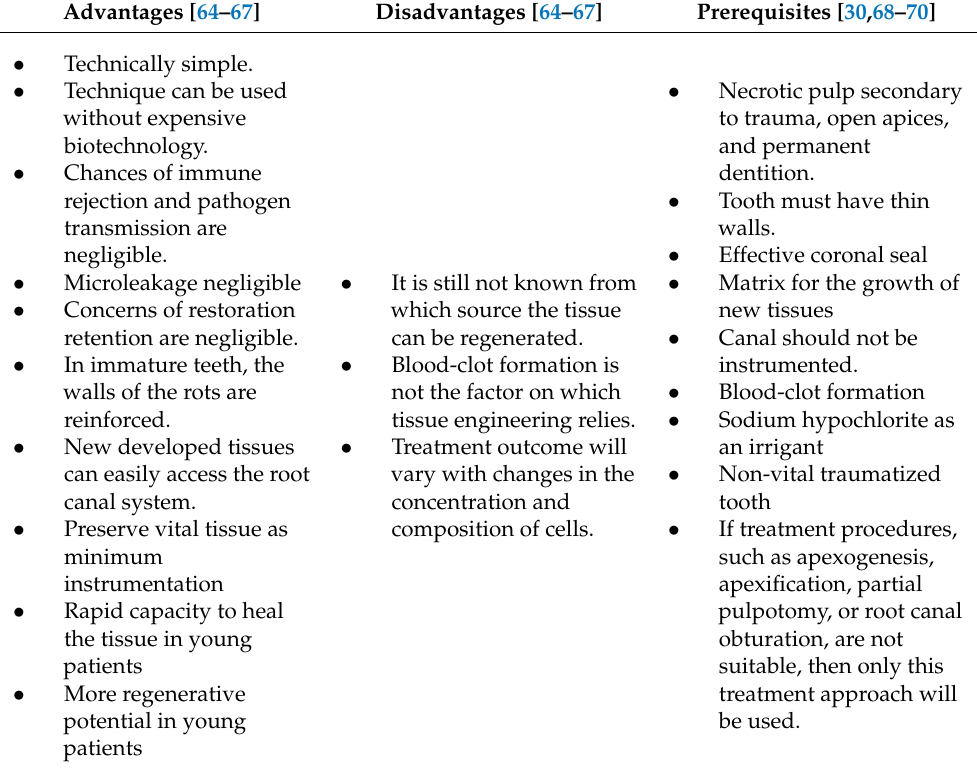
Table 1. Summary of advantages, disadvantages, and prerequisites of the revascularization